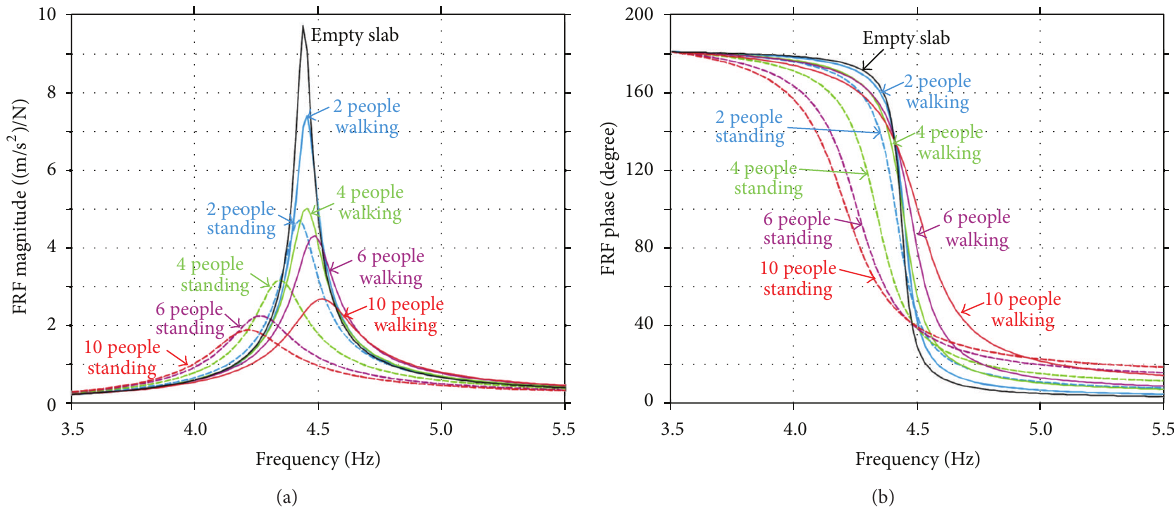
Figure 1: FRF magnitude and phase graphs of Sheffield University test footbridge understanding/walking groups of people [11].